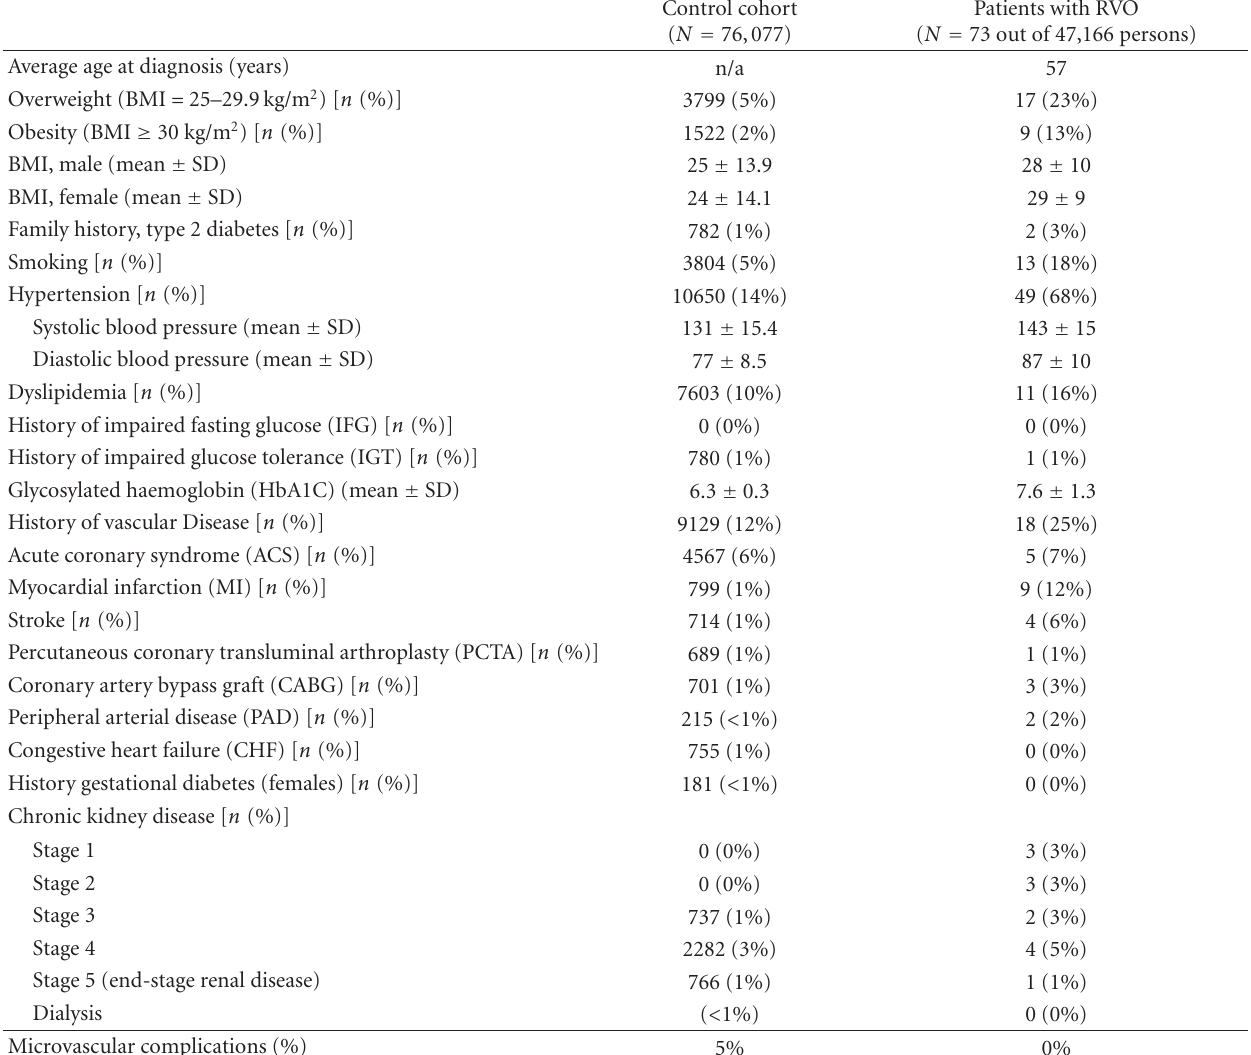
Table 2: Disease characteristics of patients with